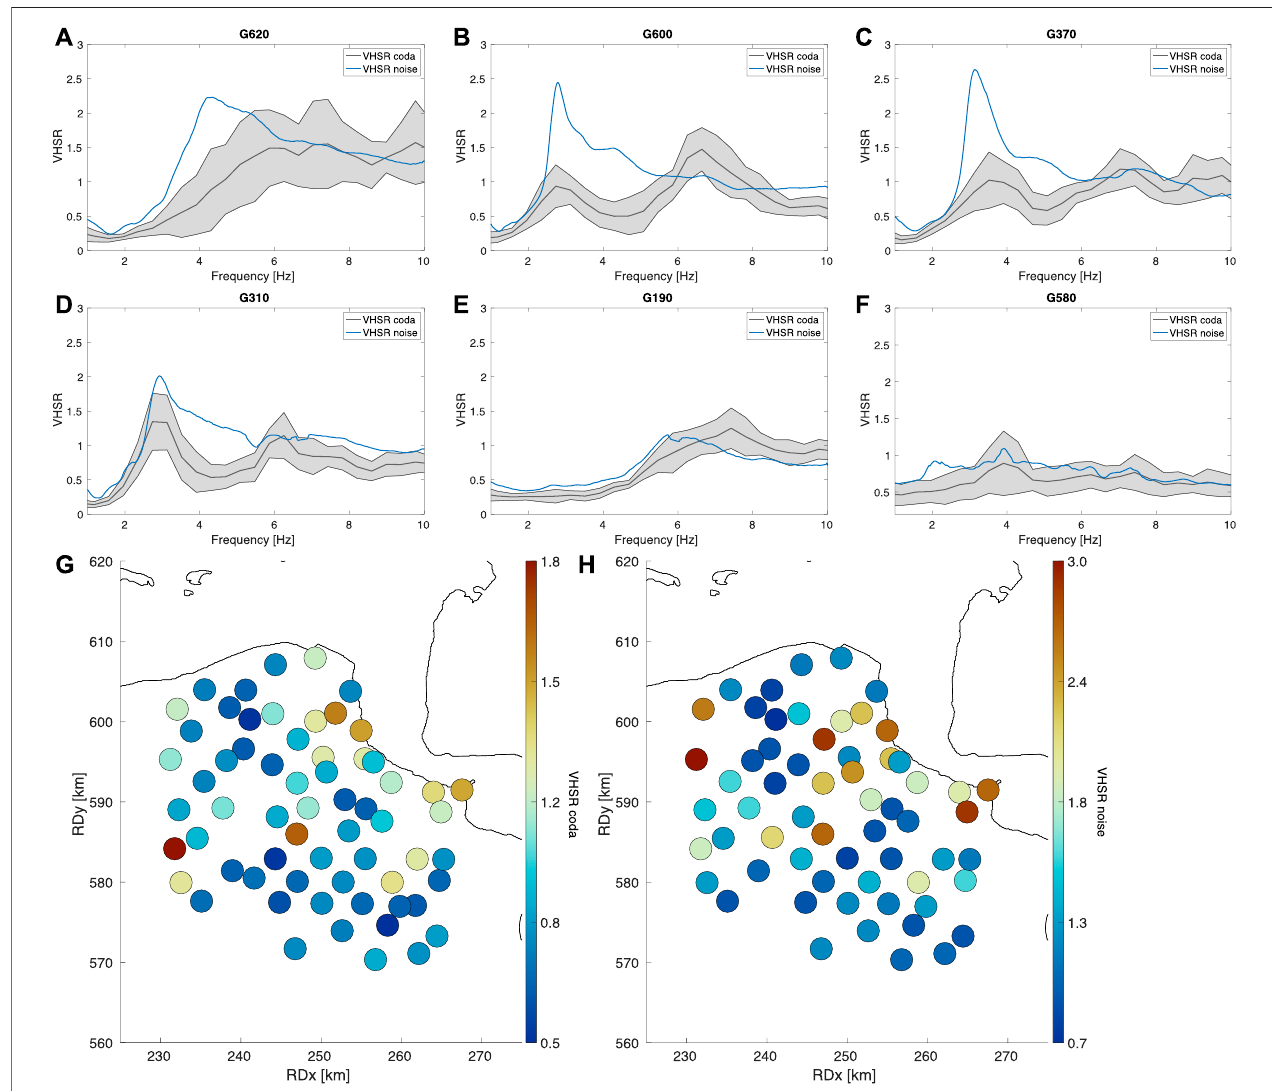
FIGURE9|(A – F) EachpaneldepictsthemeanVHSR(blackline)andstandarddeviation(dashedline)forthesurfaceseismometerforthestationsG19,G31,G37, G60,G62, where high VHSR amplitudes arecalculated. Station G58 isadded asreference toshow aVHSR for alocation withno ampli fi cation ofP-waves. Theblue line indicates the VHSR from the ambient noise fi eld. (G) Spatial distribution of coda-based VHSR peak amplitudes for each surface seismometer in the Groningen network. (H) Spatial distribution of noise-based VHSR peak amplitudes for each surface seismometer in the Groningen network.